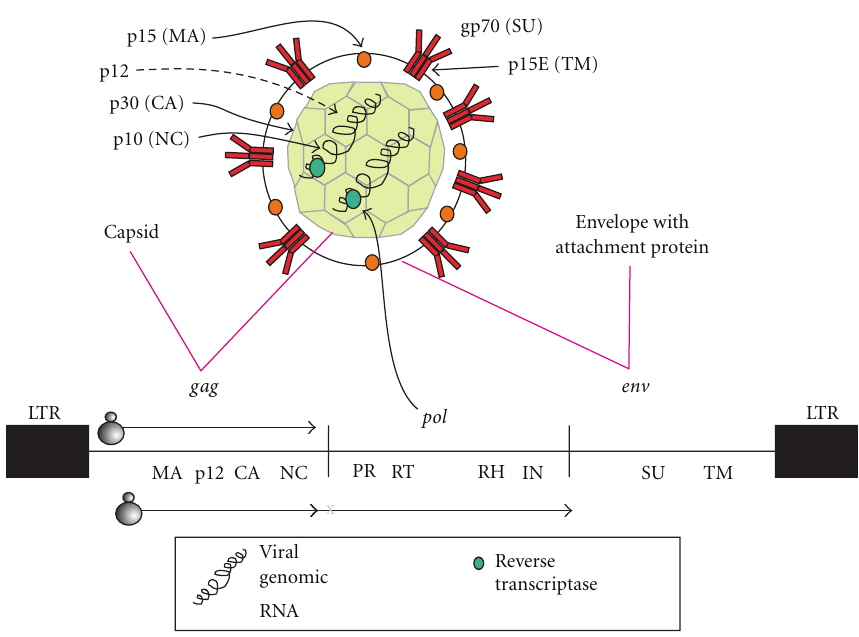
Figure 2: Structure and genome of a gammaretrovirus. The nucleocapsid is built from a hexameric lattice [46]. MA: matrix (p15), CA: capsid (p30), NC: nucleocapsid (p10), PR: protease, RT: reverse transcriptase (shown as a green dot), RH: RNAse H, IN: integrase, SU: surface unit (gp70), and TM: transmembrane protein (p15E). P12 is a small protein encoded from the portion between p15 and p30 in gag . LTR: long terminal repeat. The translation of glycoGag and normal Gag is indicated by the respective ribosome symbols. A Gag-Pol polyprotein is occasionally produced by suppression of a stop codon at the end of gag